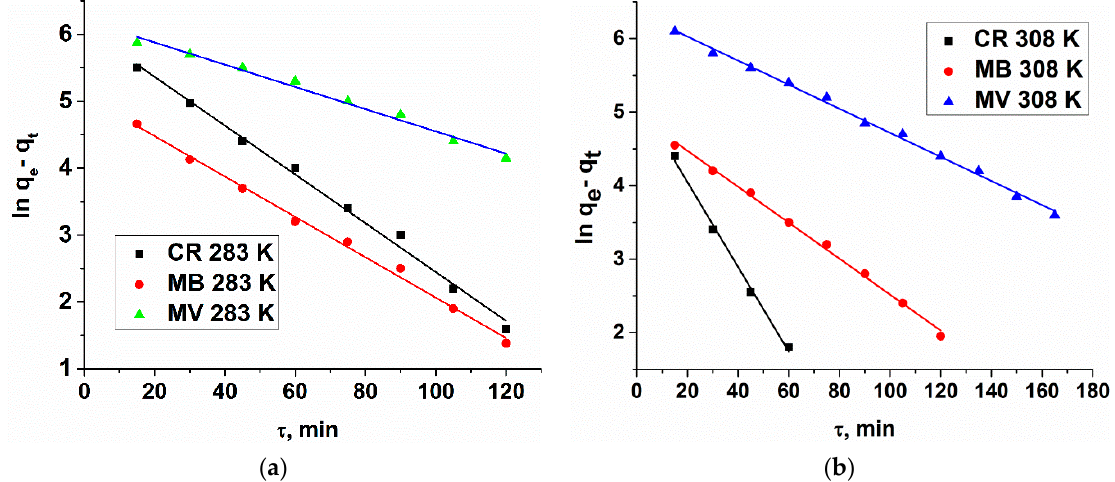
Figure 8. Modeling CR, MB, MV adsorption kinetics (linearized form) by Cu 3 (BTC) 2 · 2H 2 O (pseudo-first Figure 8 . Modeling CR, MB, MV adsorption kinetics (linearized form) by Cu 3 (BTC) 2. 2H 2 O order model) at T = 283 K ( a ) and 308 K ( b ). (pseudo-first order model) at T = 283 K ( a ) and 308 K ( b ). Table 3. Pseudo-first-order adsorption rate constants calculated graphically.